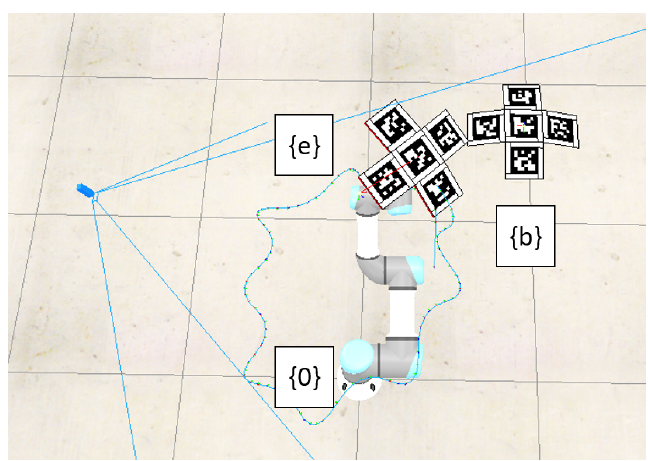
Figure 3. Simulation B with tags and a camera.